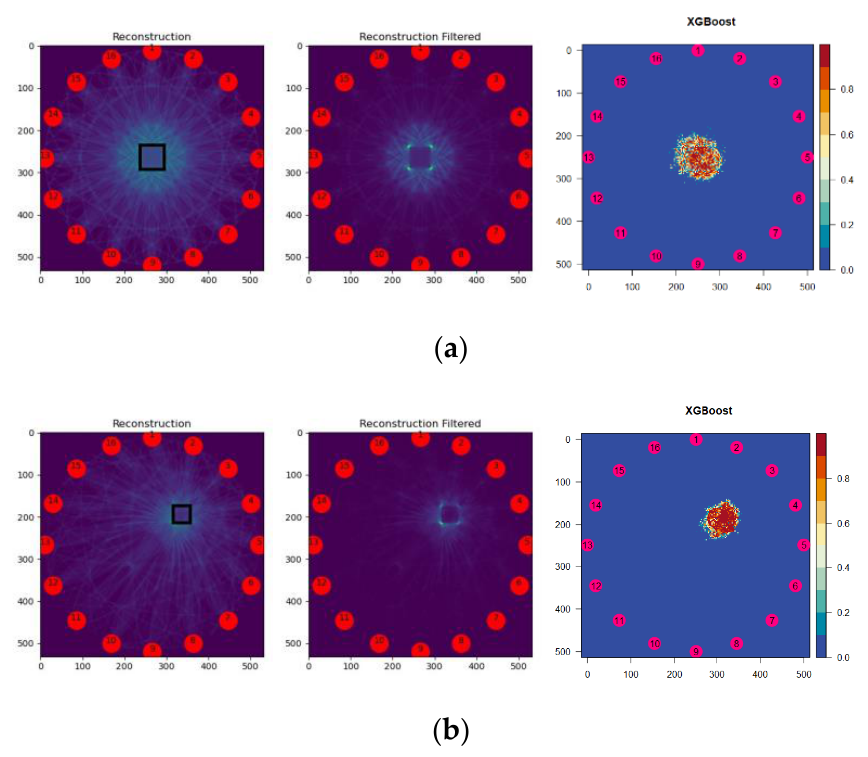
Figure 11. Each reconstructed object is labelled on the left graph, the filtered reconstruction obtained by the deterministic method is shown in the middle, and the reconstruction using the XGBoost model is shown on the right: ( a ) A regular cuboid with a base side of length 40 mm placed in the centre of a tank; ( b ) a regular cuboid with a base edge of length 30 mm placed the halfway from the centre to the tank bound (rotated through a 45-degree angle).